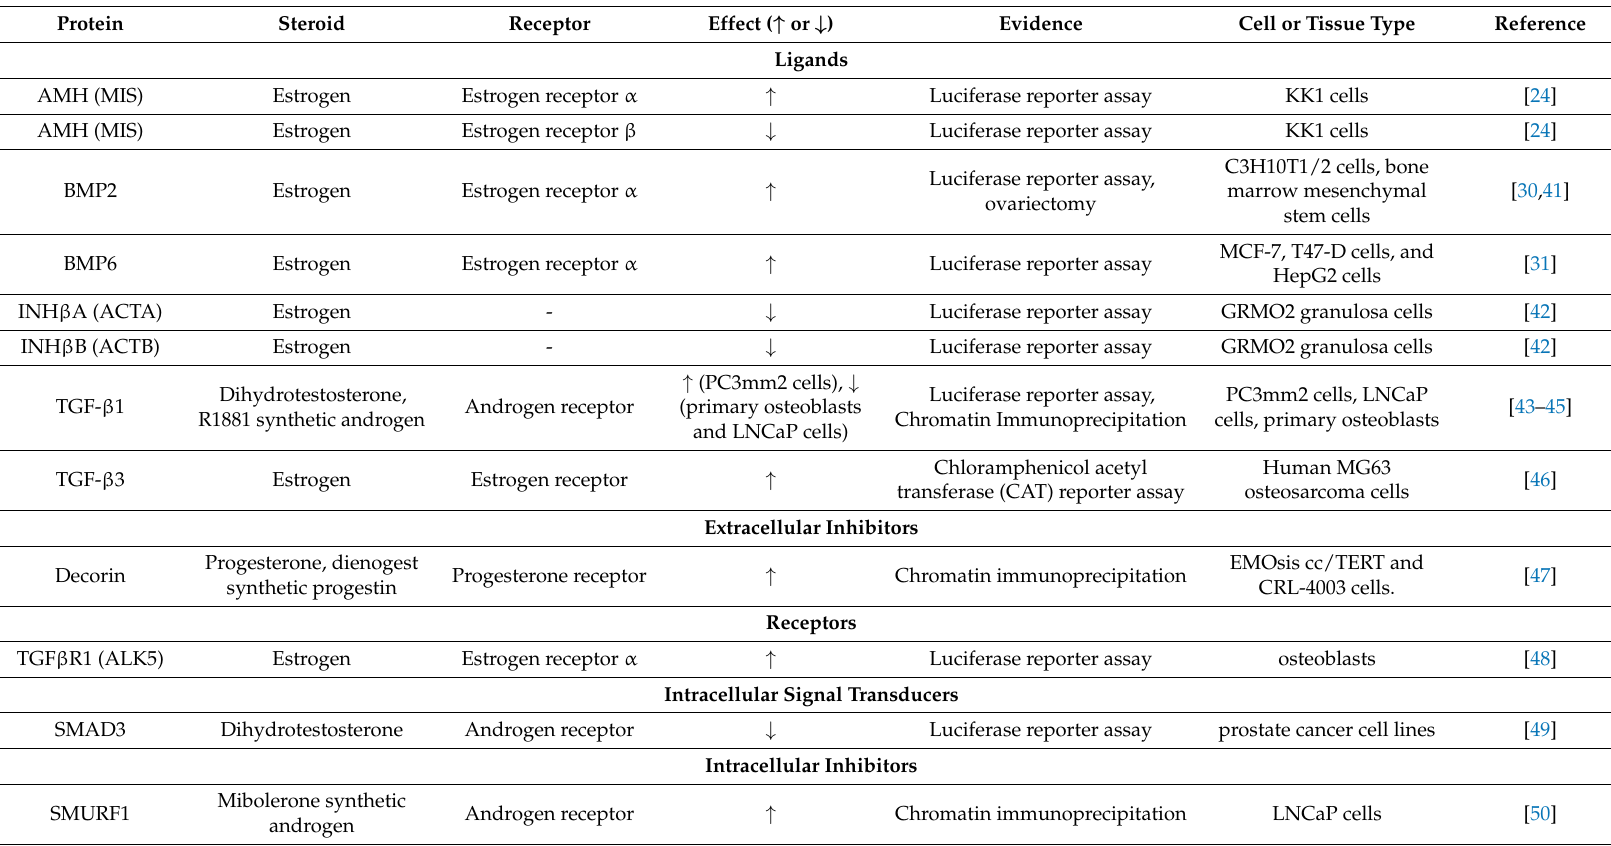
Table 1. BMP/TGF- β signaling pathway members with molecular evidence of direct regulation by sex-related